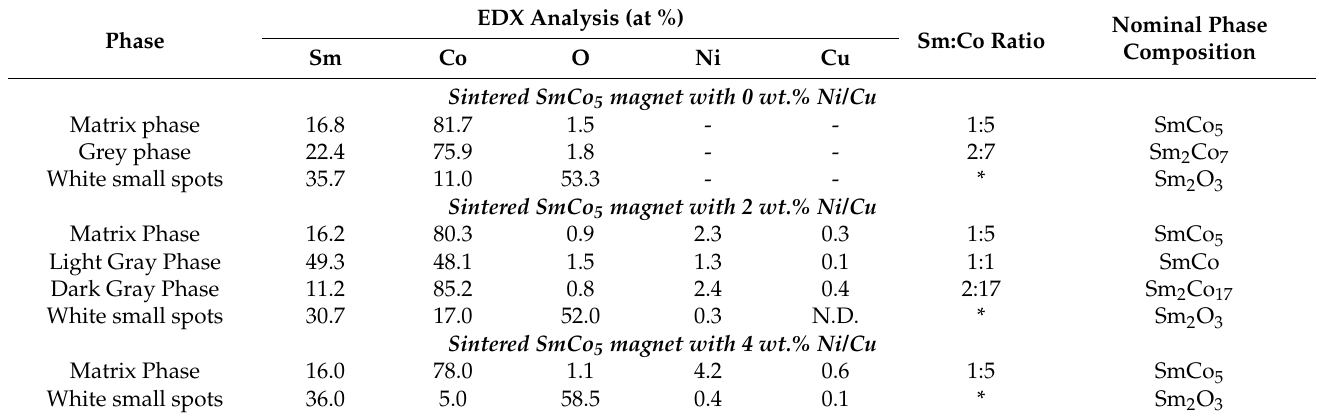
Table 3. EDX analysis for the phases in the sintered SmCo 5 magnet samples with and without Ni/Cu. EDX Analysis (at Phase